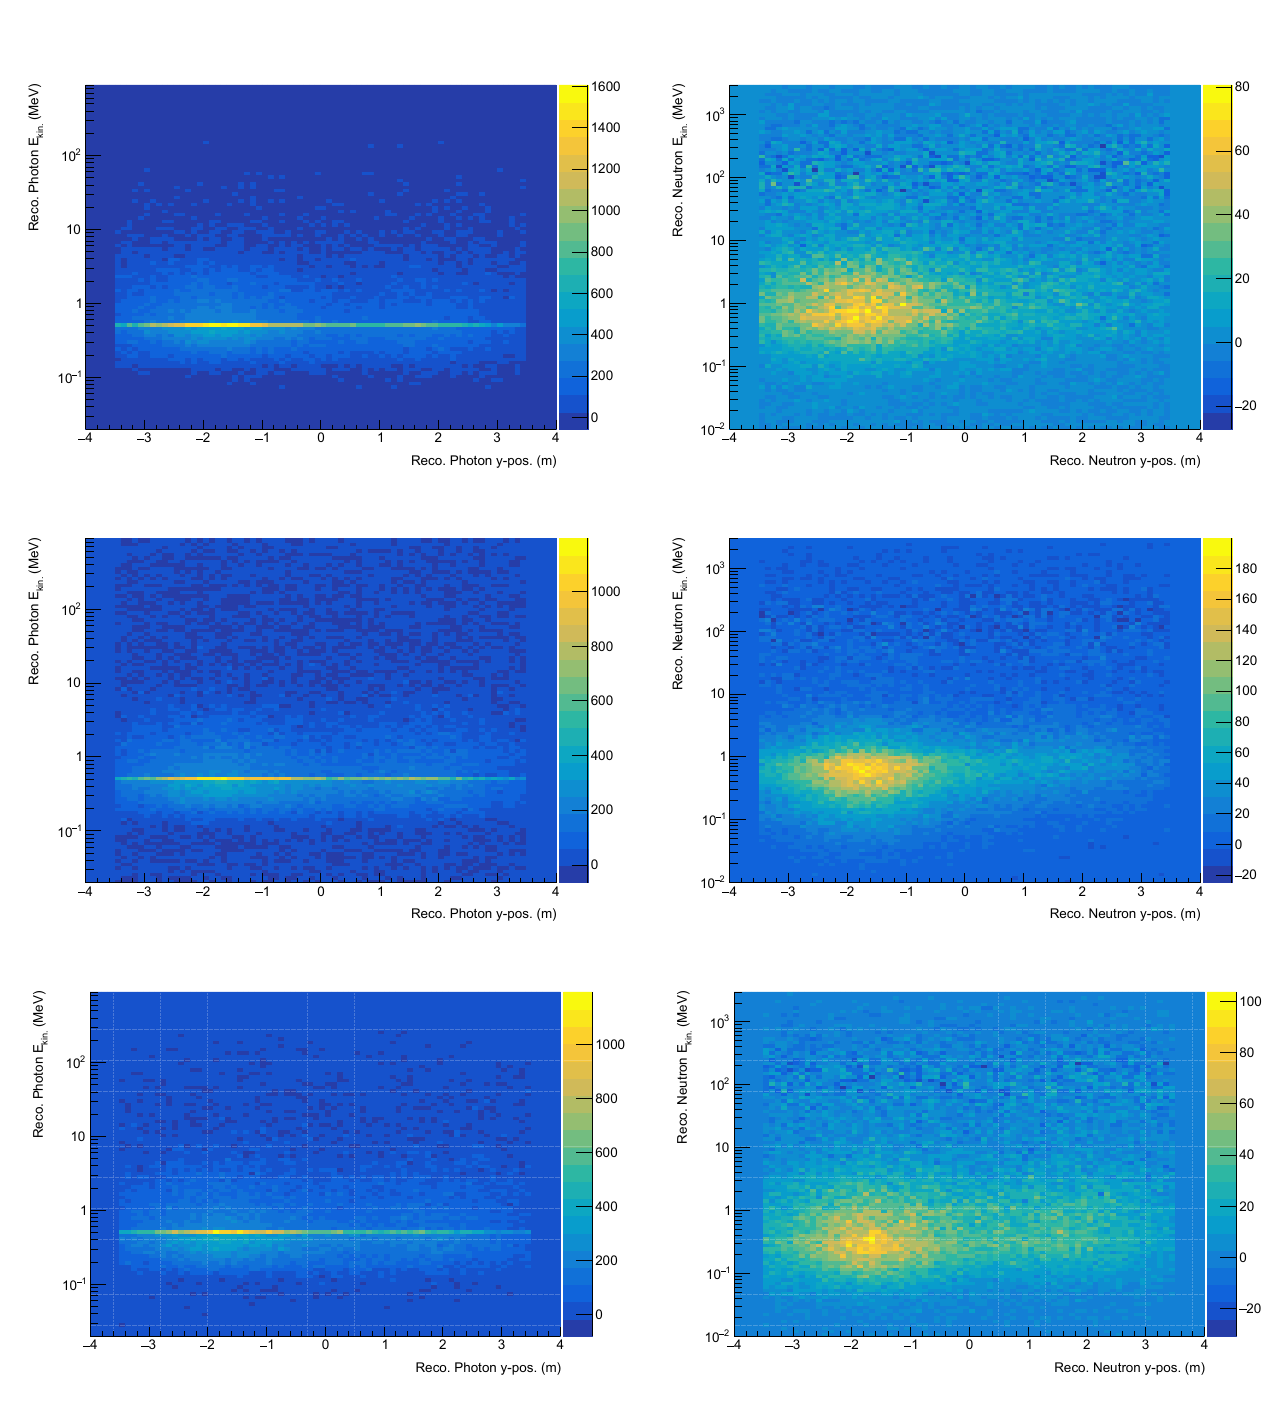
Figure 3. The distribution of the kinetic energy E kin . as a function of the y -position of the reconstructed photons ( left column ) and neutrons ( right column ) in the sidewise detector planes. The materials analyzed are Cesium ( upper row ), Tin ( middle row ) and Palladium ( bottom row ). The hits from the empty container are